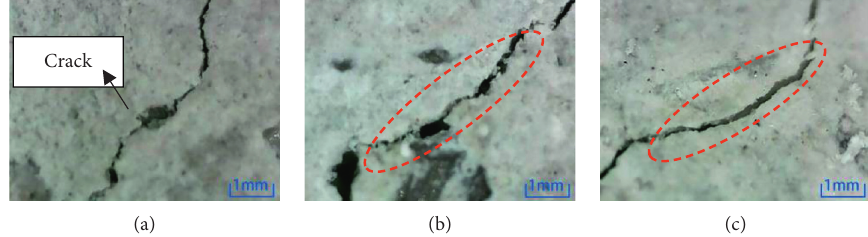
Figure 26: Microscopic observation of specimen soaked in Na